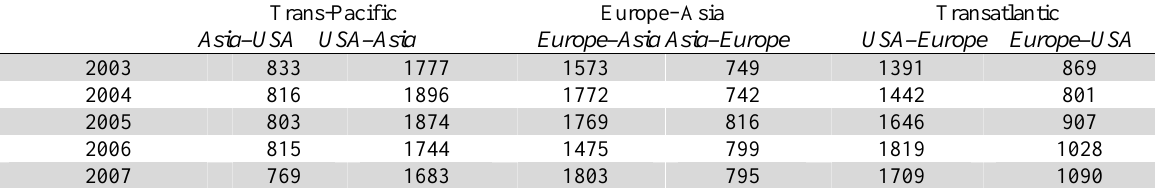
Trans-Pacific Europe–Asia Transatlantic Asia–USA USA–Asia Europe–Asia Asia–Europe USA–Europe Europe–USA 2003 833